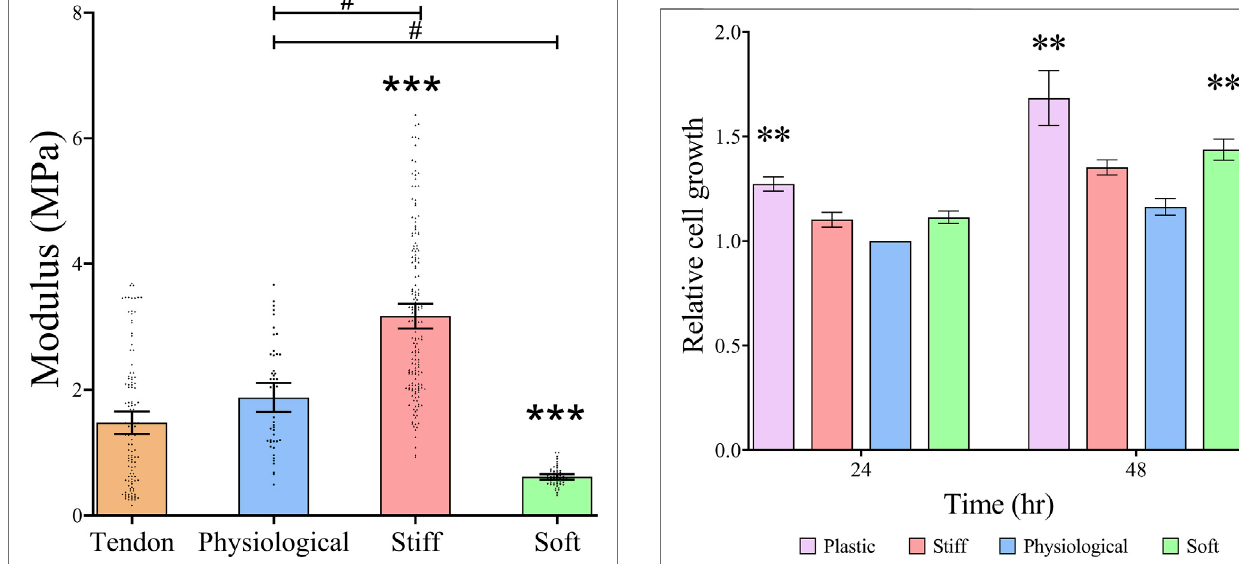
FIGURE 1 | Stiffness of Tendon slices and three formulations of PDMS gels The stiffness of the matrices was measured using AFM. Dots represent individual measurements, means and 95%CI are indicated. Stiffness of the different substrates was compared by Kruskal Wallis test. * = statistically signi fi cant compared to bovine tendon slices, # = statistically signi fi cant between gel systems, both p < 0.05.